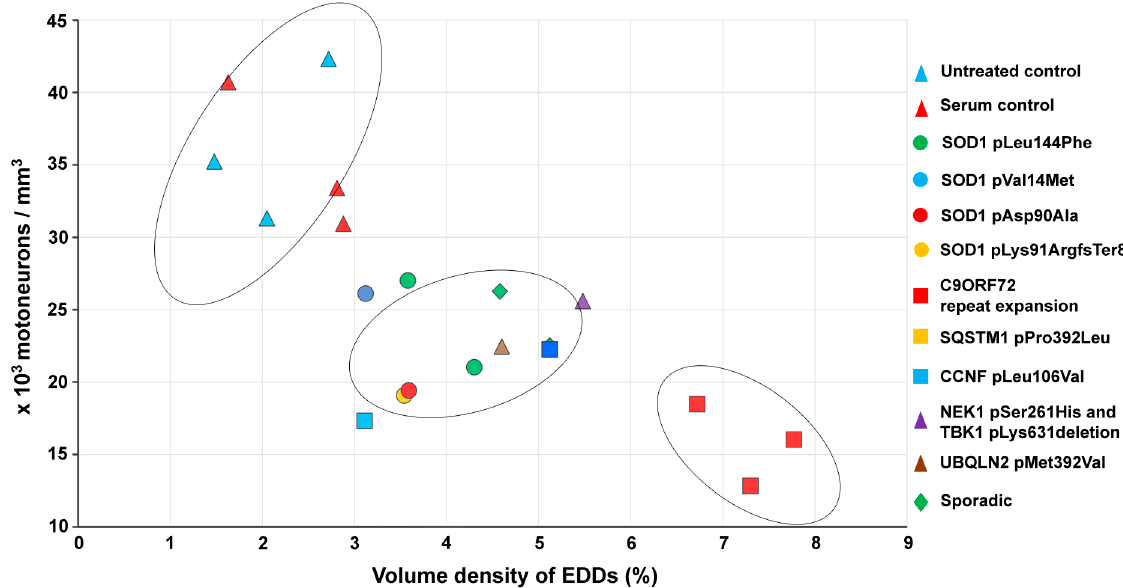
Figure 6. On the diagram (except for the untreated animals), each symbol represents a patient who served as a serum donor. Clearly, by increasing the observed intracellular calcium level (horizontal axis), the decreasing number of surviving motor neurons could be counted (vertical axis). With statistical analysis, three clusters could be identified: the control group at the left side, the majority of amyotrophic lateral sclerosis patients at the middle, and patients with chromosome 9 open reading frame 72 hexanucleotide repeats, with the most substantial effect, at the right side. For a visual representation, 99.5% confidence intervals were determined for the three clusters, drawn as ellipses around the clusters.